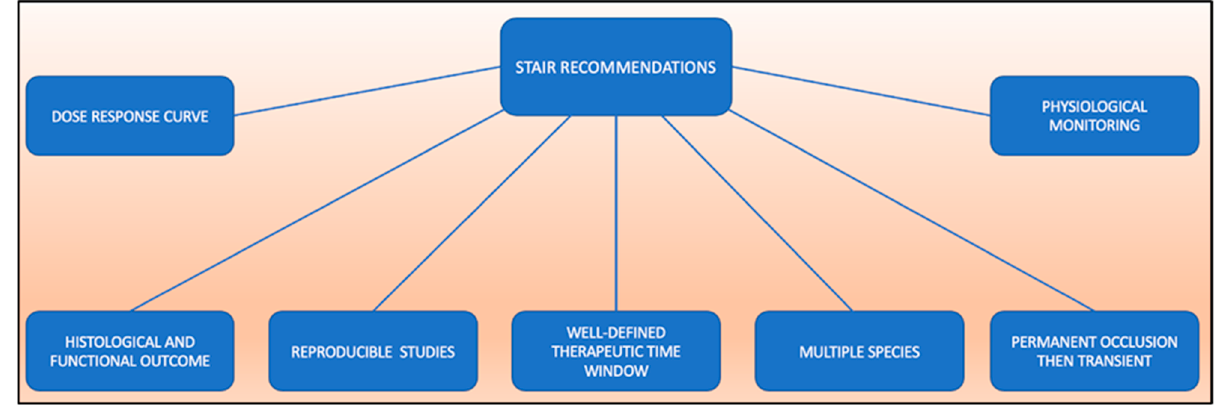
Figure 2. Overview of the Stroke Therapy Academic Industry Roundtable (STAIR) recommenda- tions.